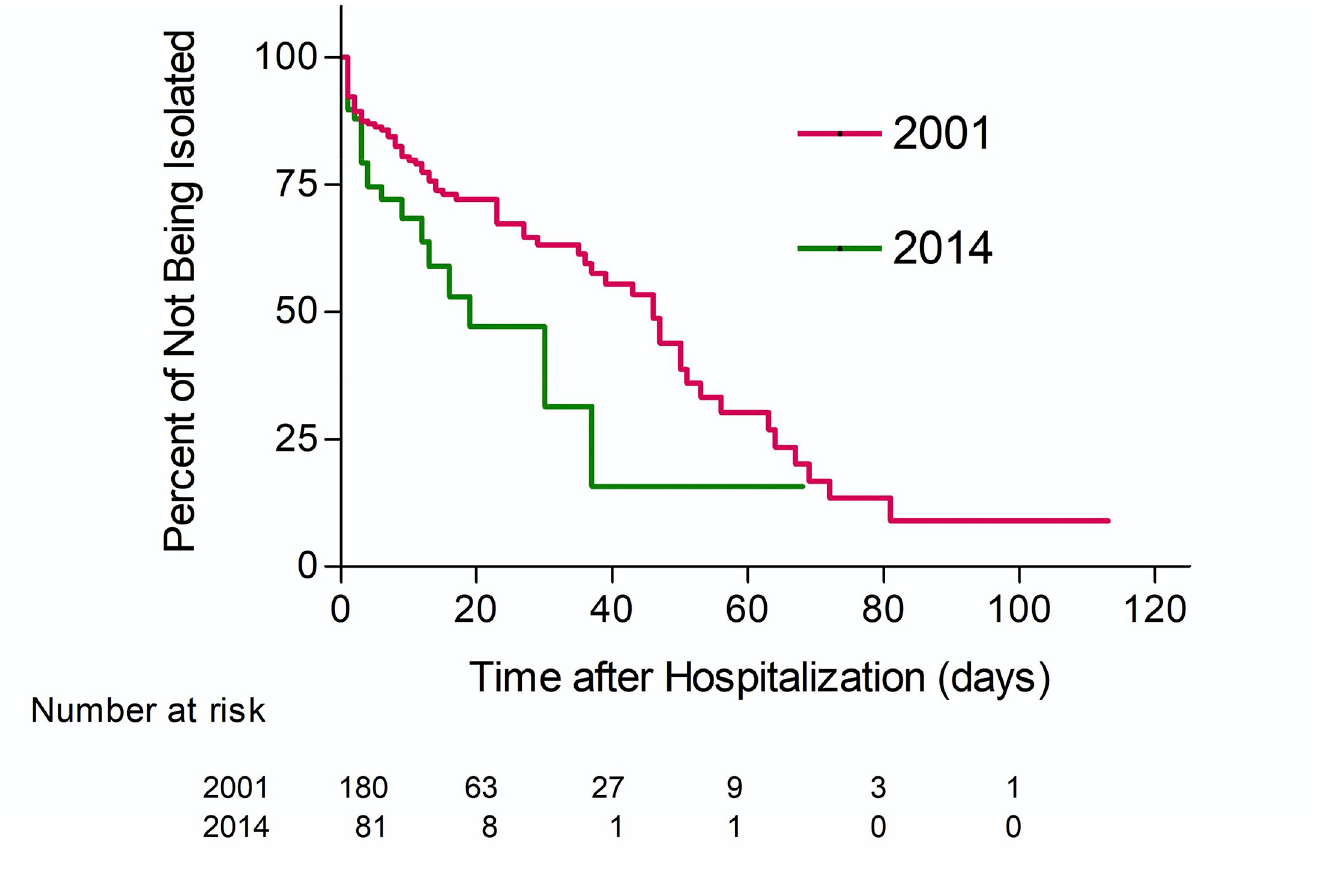
Fig 1. Kaplan-Meier estimates for time to respiratory isolation of hospitalized patients with tuberculosis, 2001 vs.